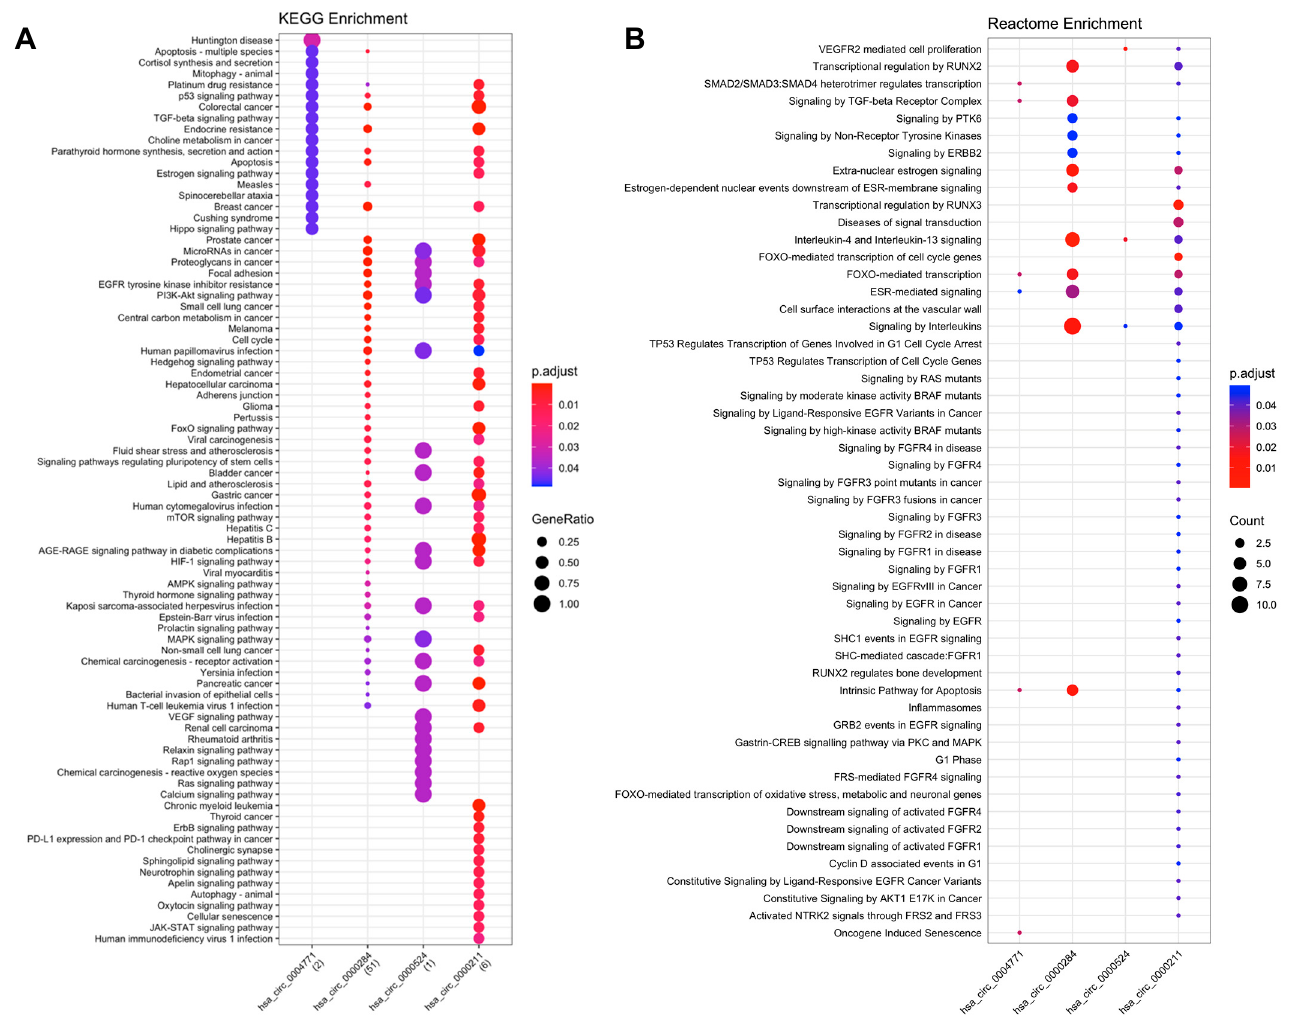
Figure 2. Functional enrichment analysis of circRNA-miRNA-mRNA interactions. ( A ) KEGG enrichment analysis; ( B ) Reactome enrichment analysis.